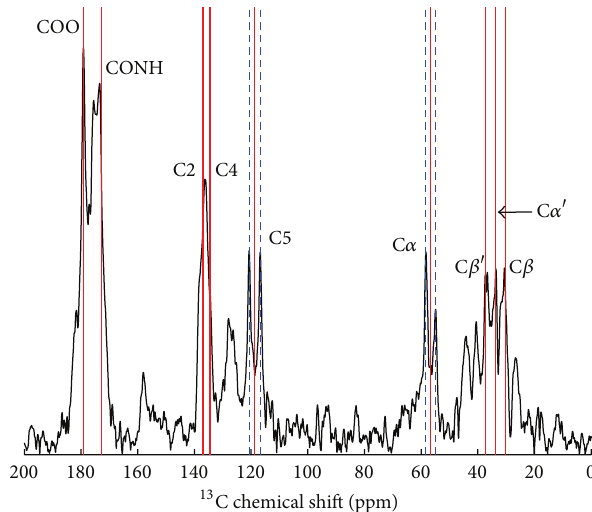
Figure 4: 13 C spectrum of the gelatin phantom in magnitude mode. Solidlinesindicatethepositionofcarnosinesignalsin 1 Hdecoupled high resolution NMR spectrum. The measured total couplings are indicated by blue dashed lines for the peaks of C 𝛼 at 56 ppm and C5 at 118